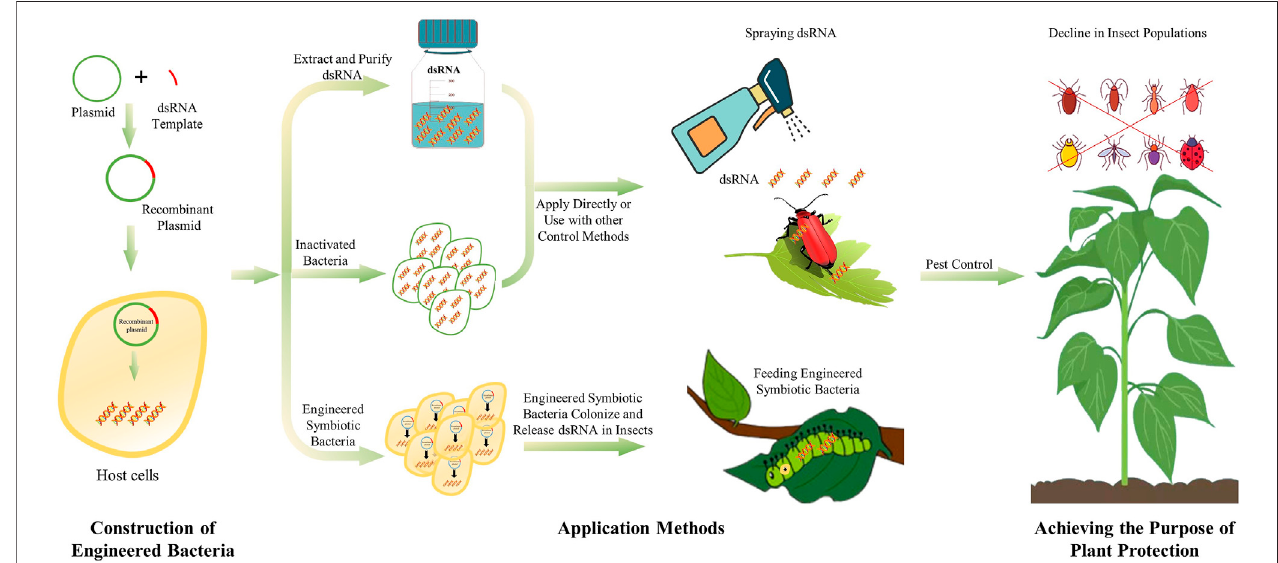
FIGURE 1 | The process and use method of microbial dsRNA production